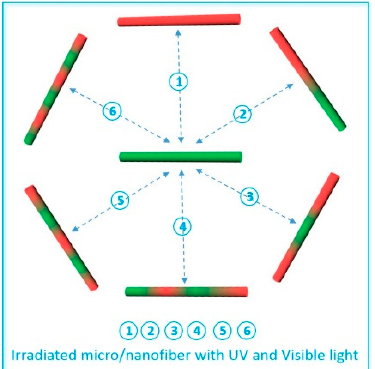
Figure 18. Schematic illustration of regulating the submicrostructure of a polymer micro/nanofiber. (1, 2, 3, 4, 5, 6 are the six examples that the micro/nanofiber was irradiated reversibly with UV and visible light of different region along the micro/nanofiber).